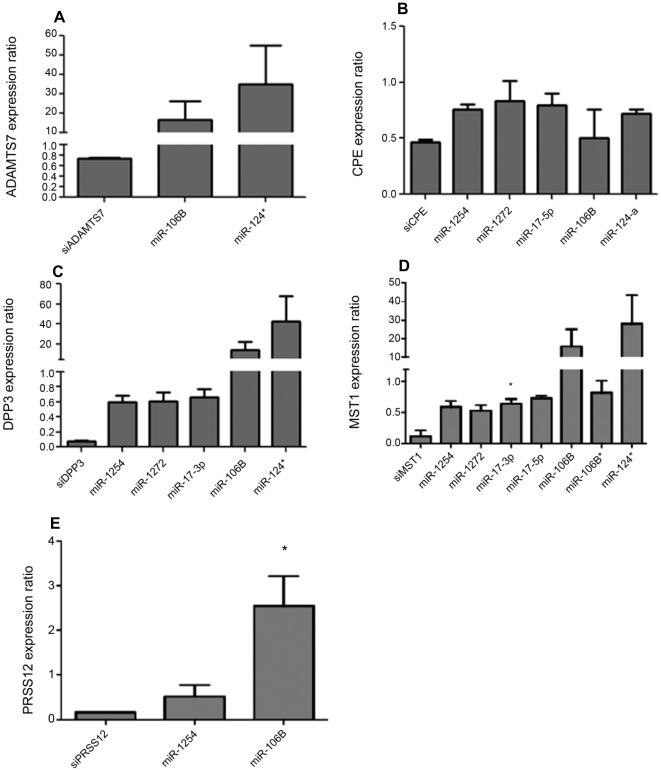
Effect of miRNA inhibition on host protease gene expression 24 h post-miRNA inhibitor treatment.Host cell miRNAs of interest were evaluated for their effect on host gene hits by qPCR. A549 cells were treated with the appropriate miRNA inhibitor (25 nM) for 24 hours. Cellular RNA was isolated 24 hpi and evaluated by qPCR for host gene expression using a SYBRgreen assay with gene-specific primers. Gene expression was compared to cells transfected with siNEG (for siRNA) or NEG (non-targeting miRNA inhibitor) at the equivalent concentration. Data is normalized to GAPDH expression. miRNAs indicated on the x-axis refer to inhibition of those miRNAs. A: ADAMTS7 expression levels, B: CPE, C: DPP3, D: MST1, E: PRSS12. Data is representative of two independent experiments. (*p<0.05 versus siRNA treatment.).